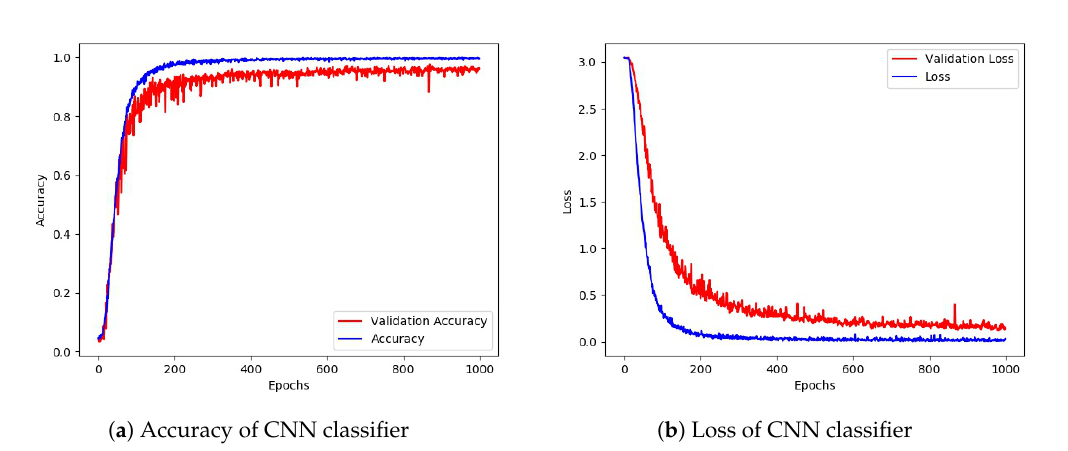
Figure 9. Accuracy and loss of convolutional neural network (CNN) classifier for training.